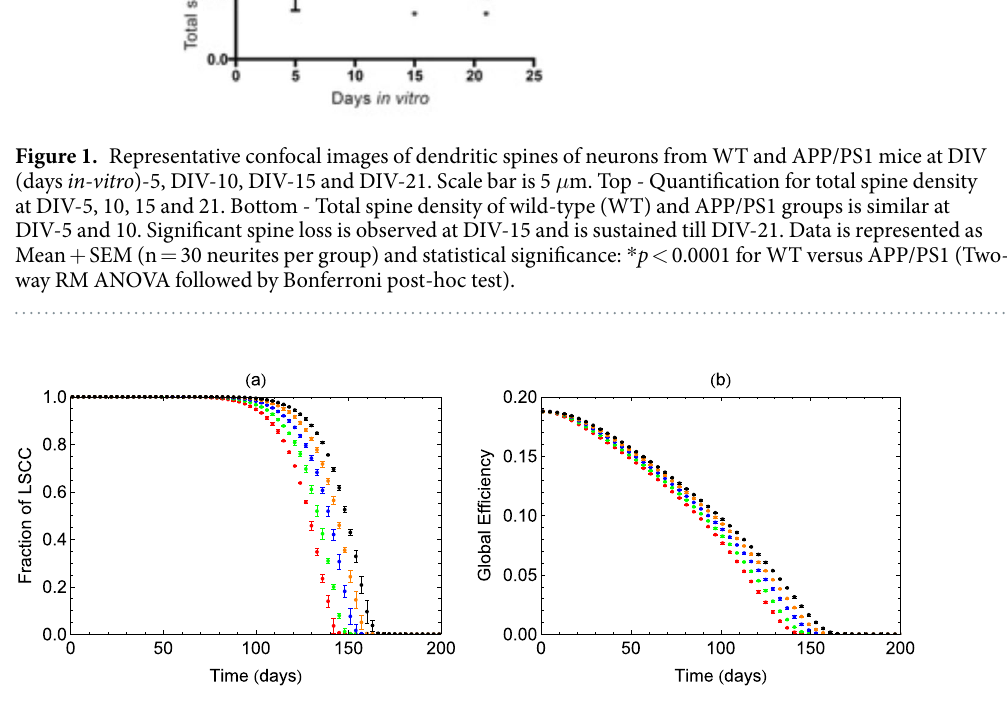
Figure 2. Decrease in the fractional size of LSCC ( a ) and Global Efficiency ( b ) with the loss of synapses or strength of connections in the network. Decay of links is studied for values of τ = 20, 25, 30, 35, 40 (left to right). We observe that changes in τ , that can take care of variations in individual patient responses or various animal models, give qualitative similar behaviour of LSCC. However, higher values of τ indicating slower decay, result in higher value of critical time Tc